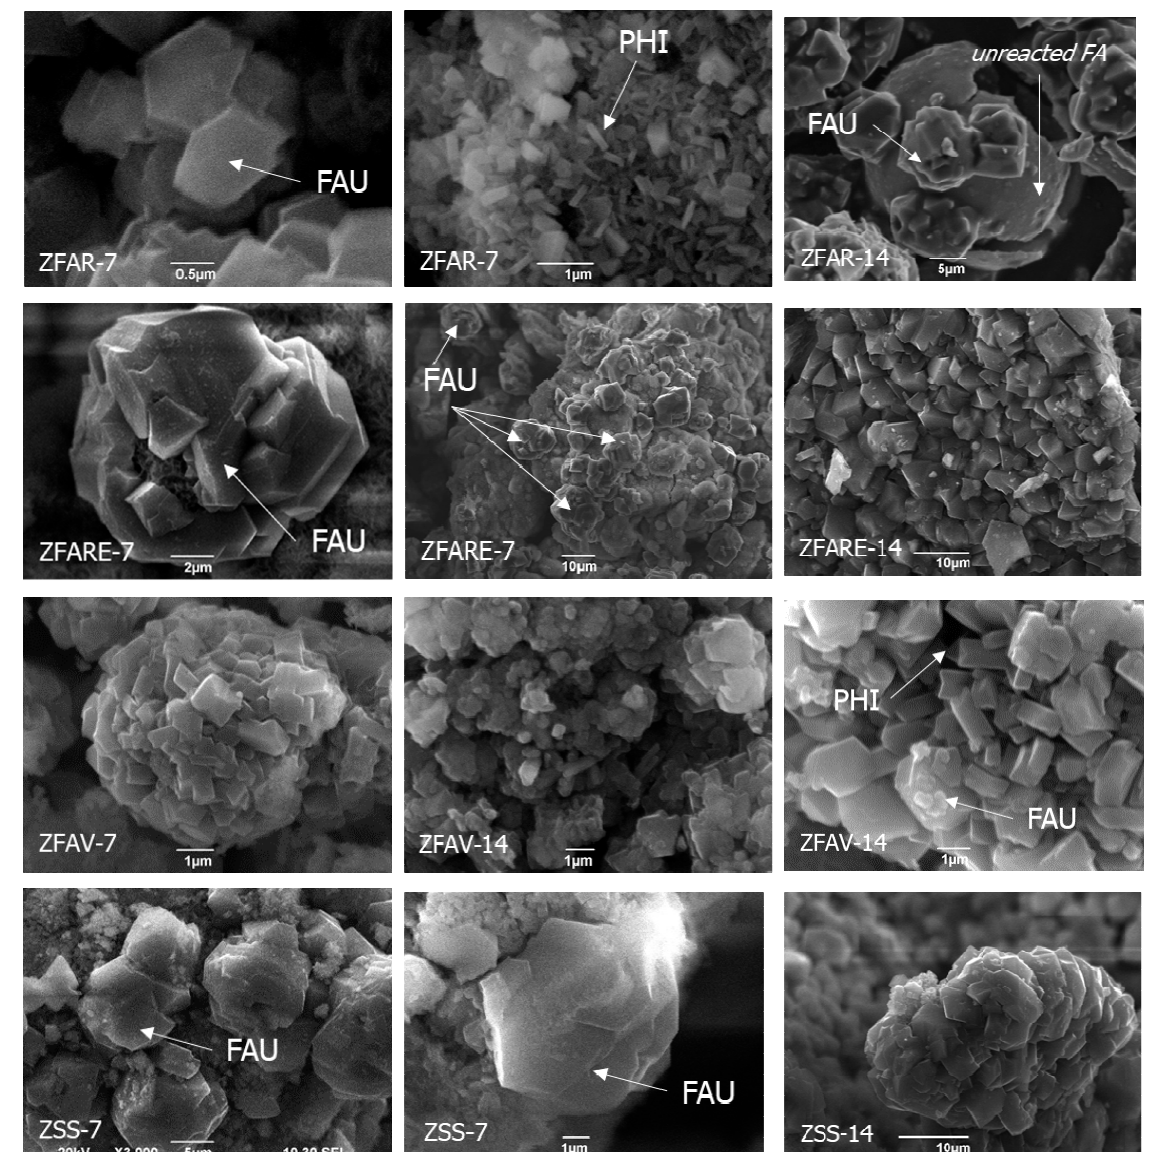
Figure 3. SEM images of fly ash zeolites obtained by FAR, FARE, FAV and SS after 7 and 14 months of crystallization.